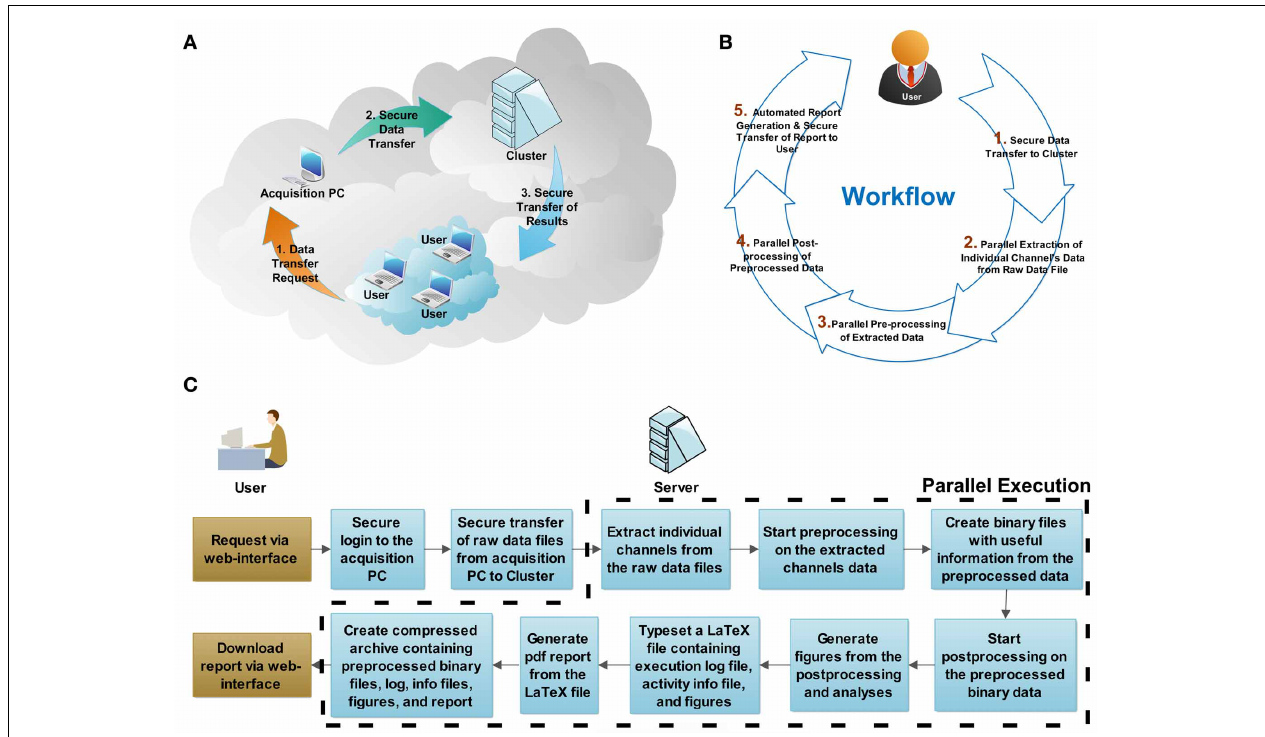
FIGURE 2 | System architecture and workflow description. The physical configuration of computers within network(s) is reminiscent (A) of a cloud-computing architecture. Through a web browser, the user initiates (B) the workflow by requesting secure data transfer from the acquisition computer to the server, and by starting the parallel batch processing and analysis. At the end of the analysis, the server generates automatically a portable document format (PDF) document, reporting on the execution